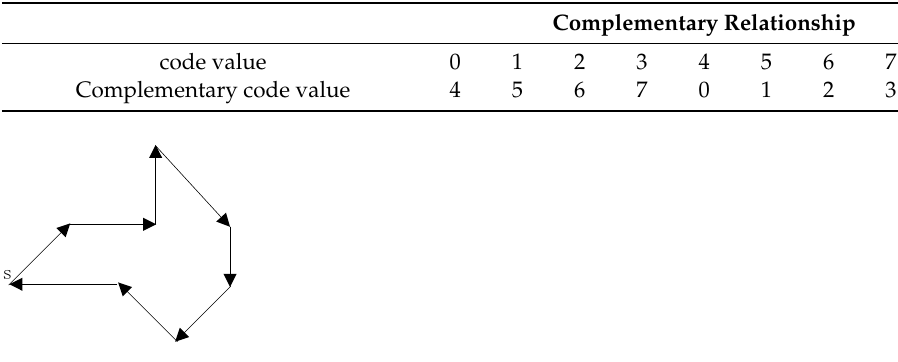
Table 1. Complementary relationship of eight-way chain code values.